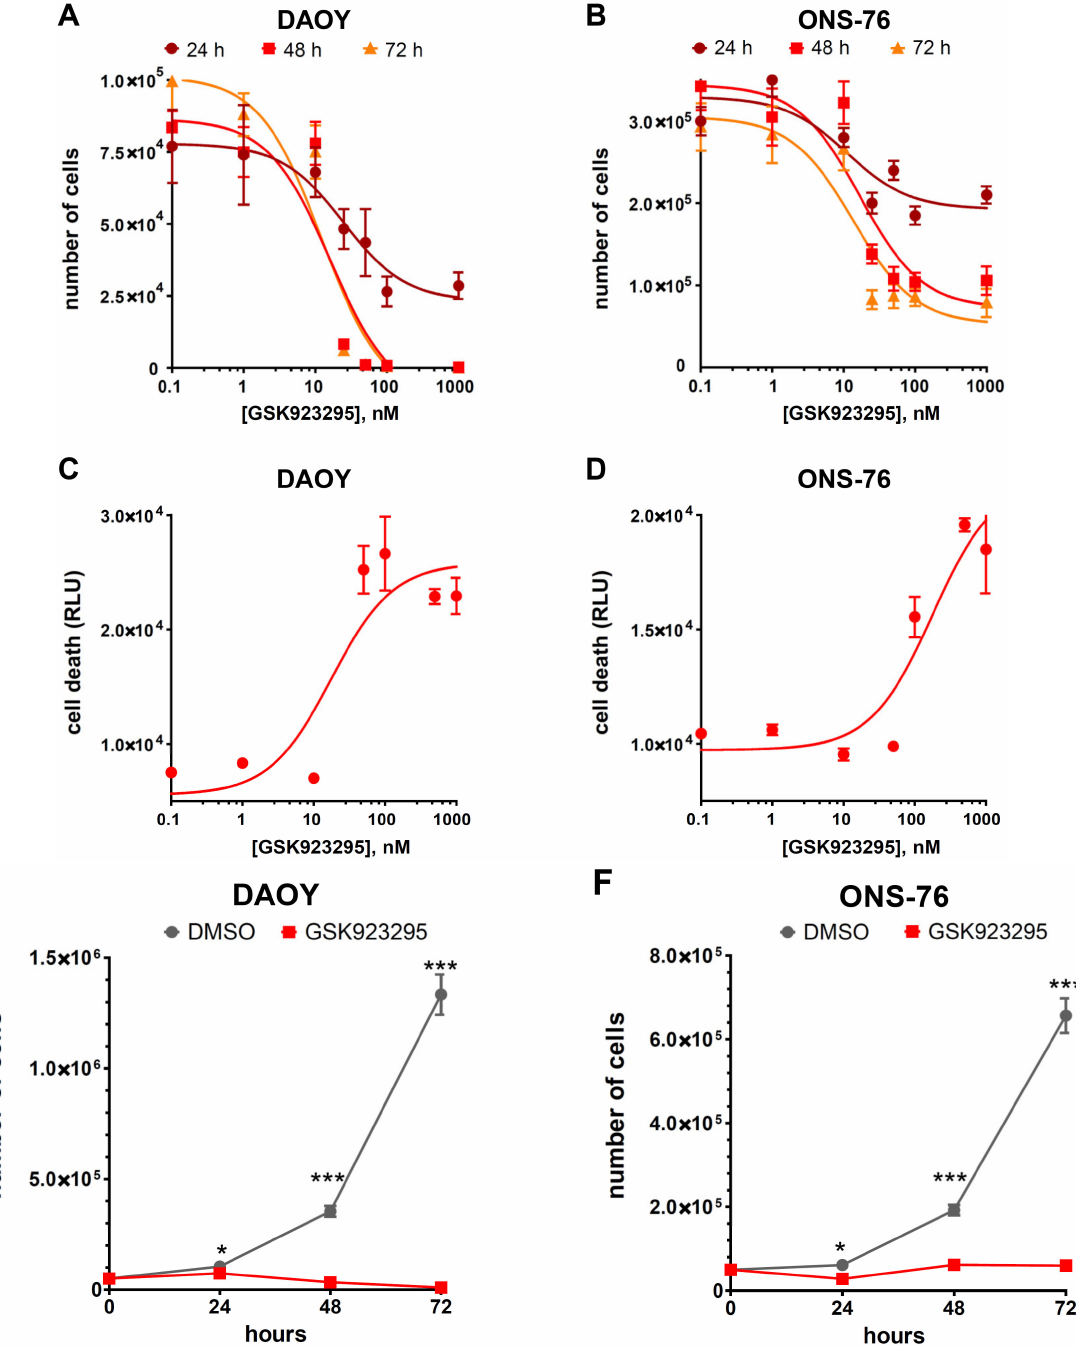
Figure 4. CENPE inhibition reduces cell proliferation and induces cell death. ( A , B ) Dose response curve of DAOY and ONS-76 cells, respectively, 24, 48 and 72 h after treatment with GSK923295. ( C , D ) DAOY and ONS-76 cell death, measured by CellTox™ Green Cytotoxicity assay, 24 h after treatment with DMSO or GSK923295. Values are plotted as Relative Light Unit (RLU). ( E , F ) DAOY and ONS-76 proliferation assay: 50,000 cells were treated with DMSO or 25 nM GSK923295. Growth curves were obtained by assessing cells’ number in each well 24, 48 and 72 h after treatment. All quantifications were based on at least three independent biological replicates. Error bars, SEM; *, p < 0.05; ***, p < 0.001; two-tailed Student t